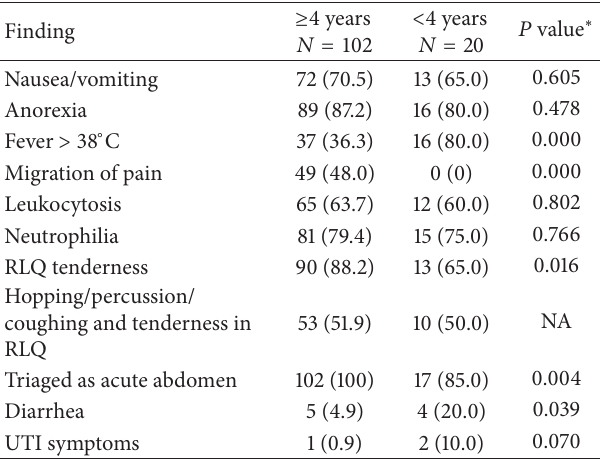
Table 4: Symptoms and clinical findings in older and younger patients.